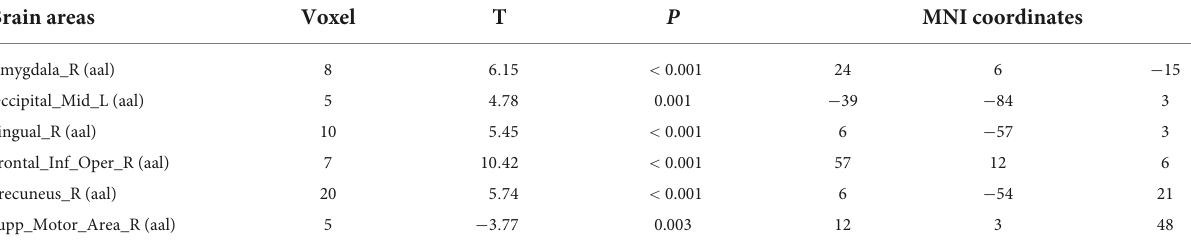
TABLE 4 Differences in brain regional homogeneity (ReHo) among participants in test 1 for the baseline state with participants in the dehydration state in test 2. Brain areas